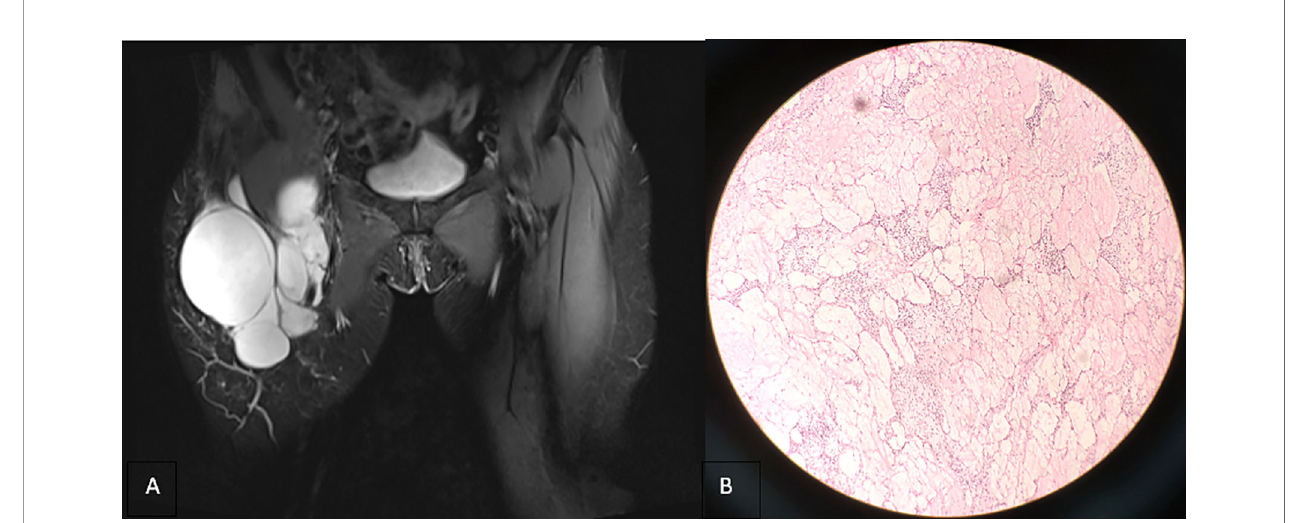
FIGURE 2 | (A) Coronal T2-weighted imaging (2013) revealing that the lesion is still con fi ned to the right inguinal area with uniform signal intensity and smooth cyst wall. (B) Microscopically, a number of dilated lymphatic vessels of different sizes are observed, the endothelial cells are slightly dense, the size of the nucleus is slightly different, and atypical cells are observed (hematoxylin and eosin stain, ×100).